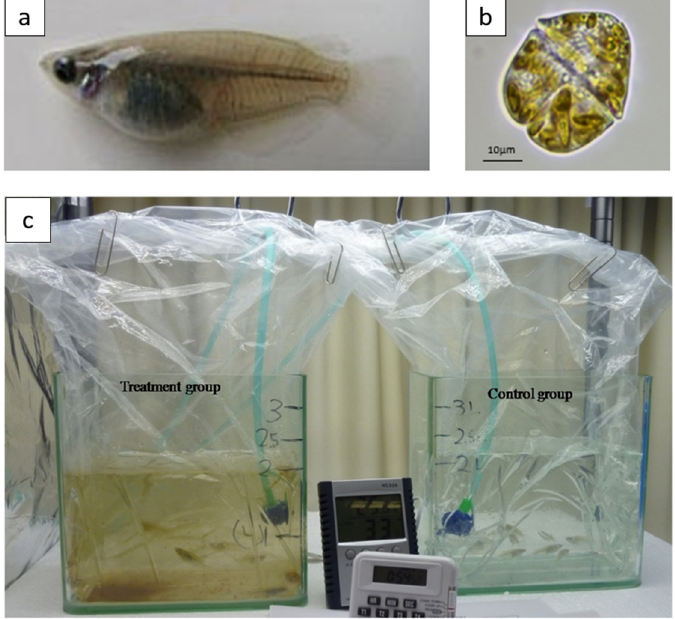
Figure 6. Marine medaka experimentally exposed to K. mikimotoi . ( a ) A lateral view of a marine medaka fish; ( b ) Microscopic image of K. mikimotoi strain isolated from Yim Tin Tsai, Hong Kong; ( c ) Setup of the ichthyotoxicity experiment ( left tank: treatment group; right tank: control group).